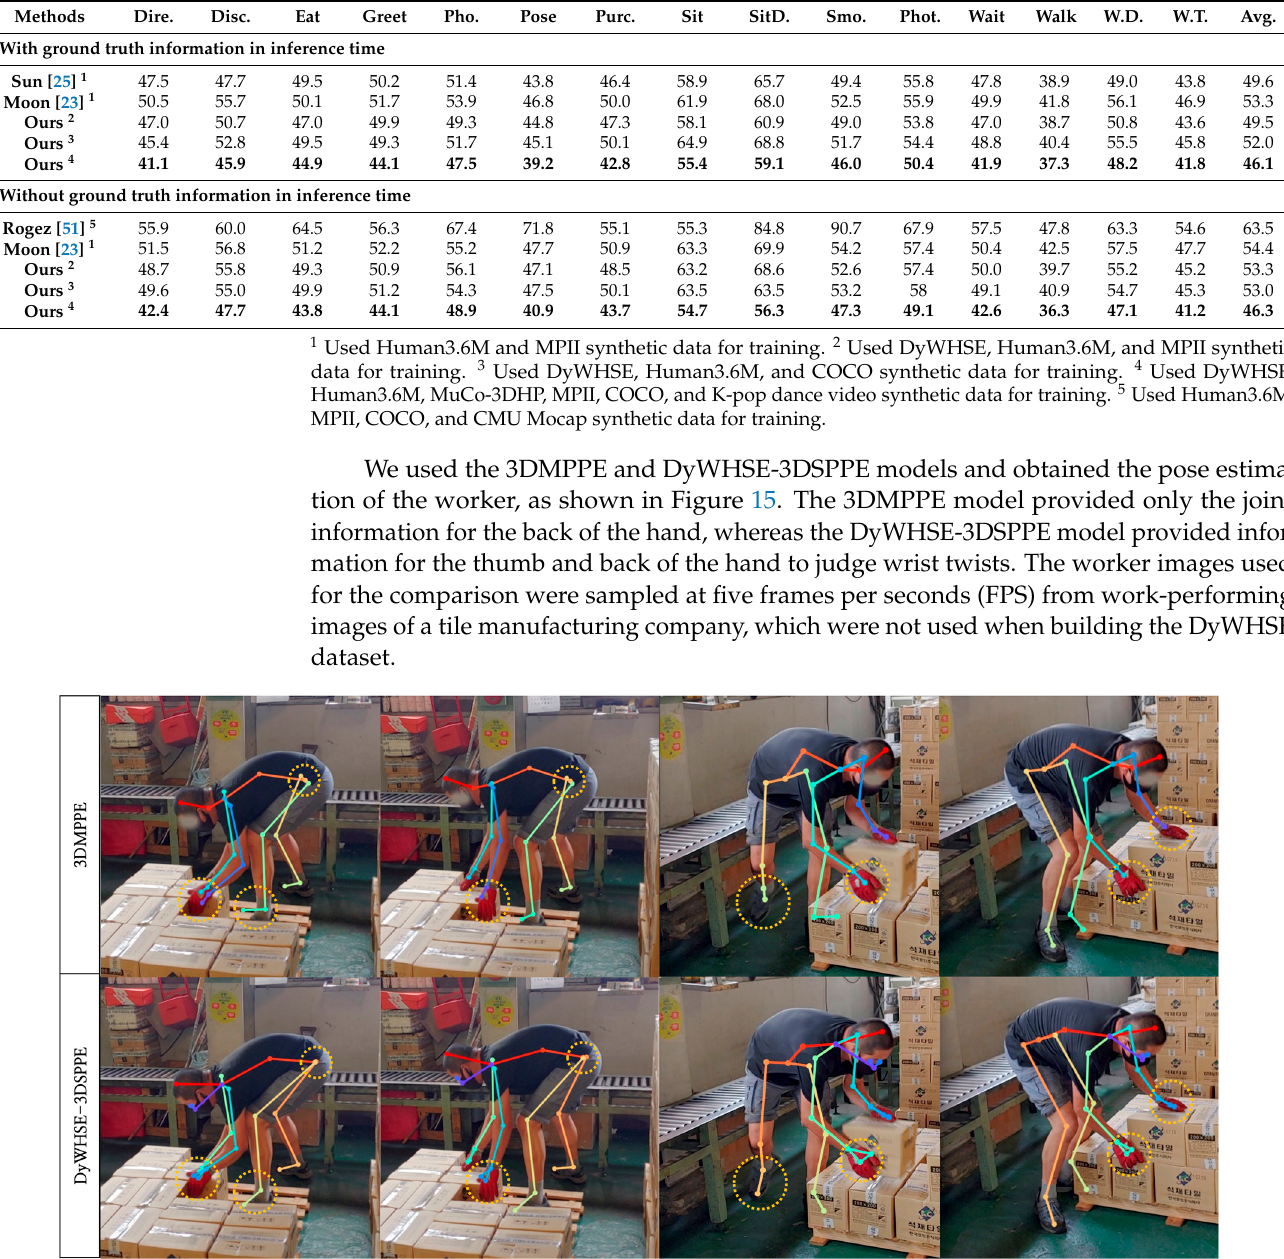
Table 3. Quantitative comparisons with the base model on the Human3.6M under Protocol 2 (MPJPE). Best results are in bold.